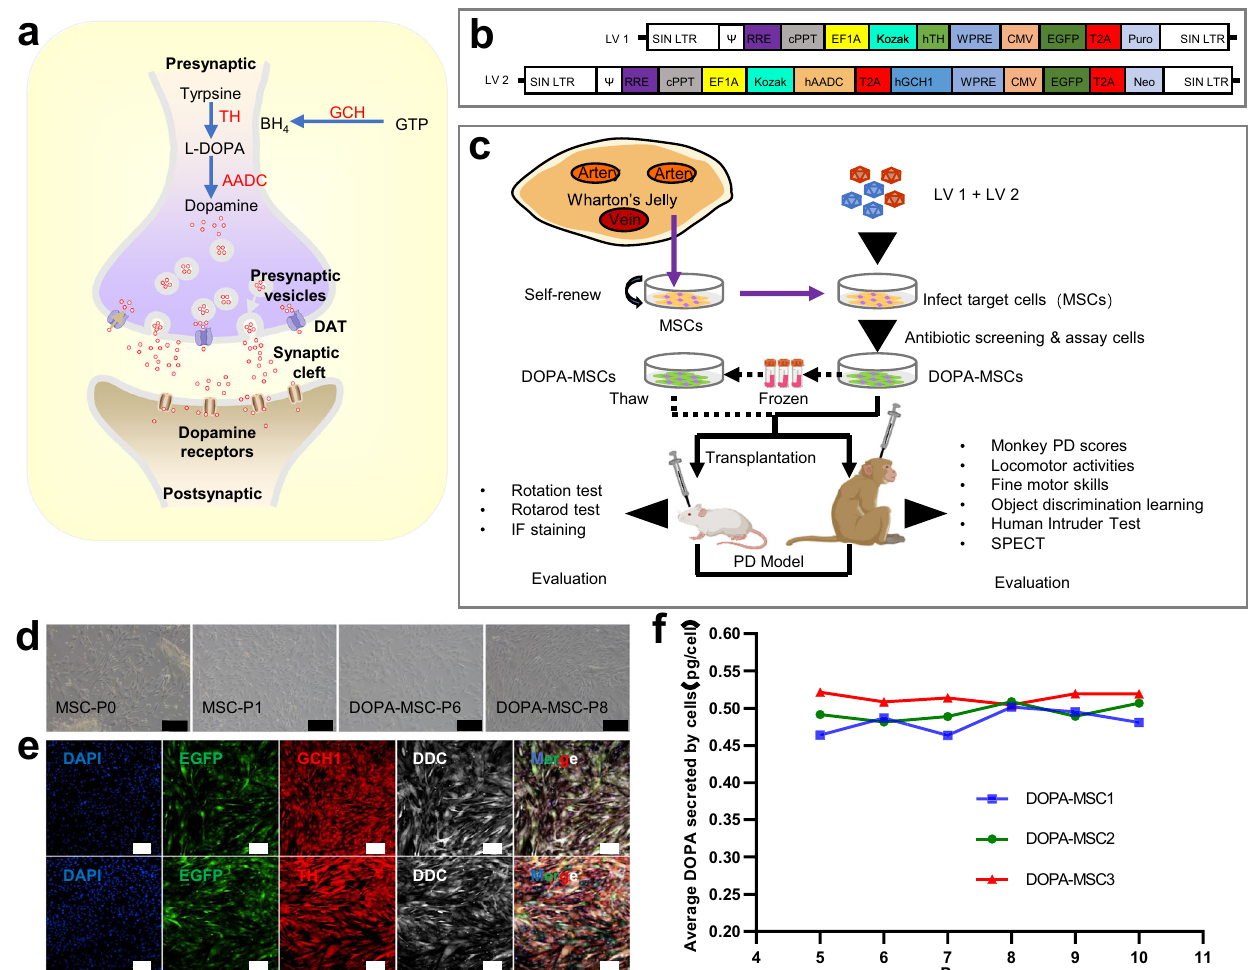
Fig. 1 Establishment of DOPA-MSCs that can stably secrete dopamine. a Dopamine biosynthetic route. AADC, TH, and GCH1 are three critical enzymes involved in dopamine biosynthesis. DAT dopamine transporter. Adapted from ref. 78 . DAT element obtain Licensing Rights from BioRender.com. b Schematic diagram showing two vector structures of the lentiviruses carrying human AADC , TH, and GCH1 . c A schematic of the experimental process. Apart from elements created by our co-authors, other elements were created with BioRender.com. d Morphological characteristics of MSCs (P0, P1) and DOPA-MSCs (P6, P8). Scale bars: 100 μ m. e TH staining of DOPA-MSCs showing coexpression of EGFP, TH, DDC, and GCH1. Scale bars: 200 μ m. TH tyrosine hydroxylase, DDC dopa decarboxylase, GCH1 GTP-cyclohydrolase 1. f Secretion of dopamine DOPA-MSCs during passaging assayed by a dopamine ELISA Kit. Three independent cell lines were